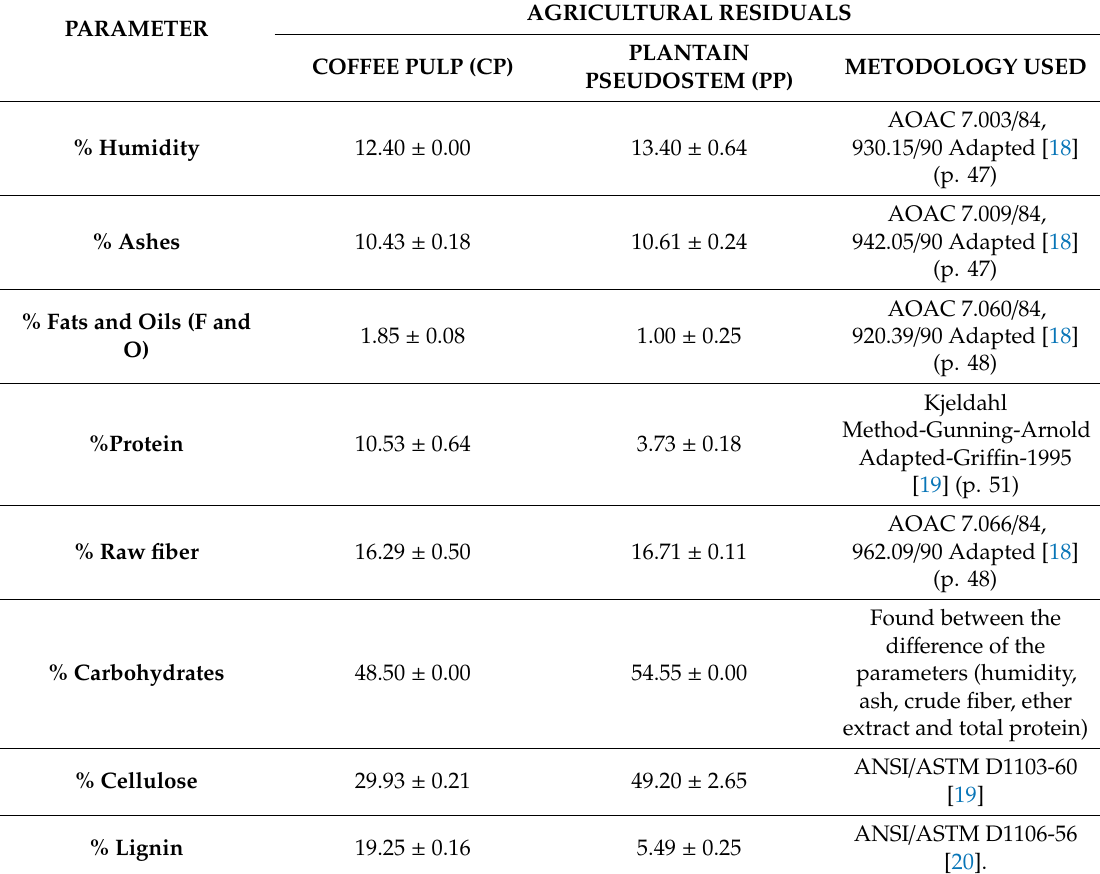
Table 1. Data of bromatological analysis, cellulose and lignin in agricultural